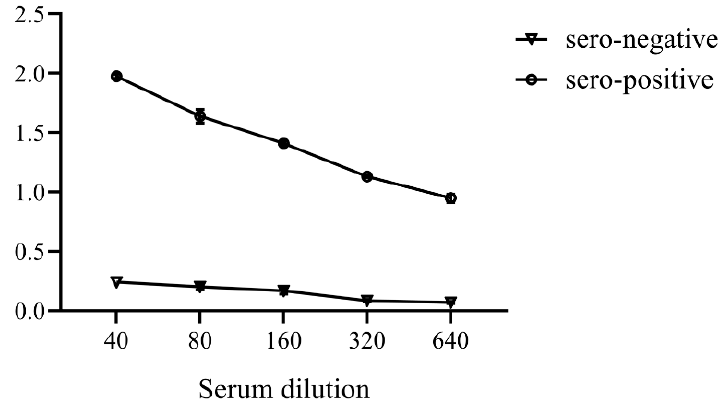
Figure 3. A titration curve for Flavobacterium columnare seropositive and seronegative serum samples (mean ± SEM) from tilapia appeared linear across the serum dilution range used in the indirect ELISA.